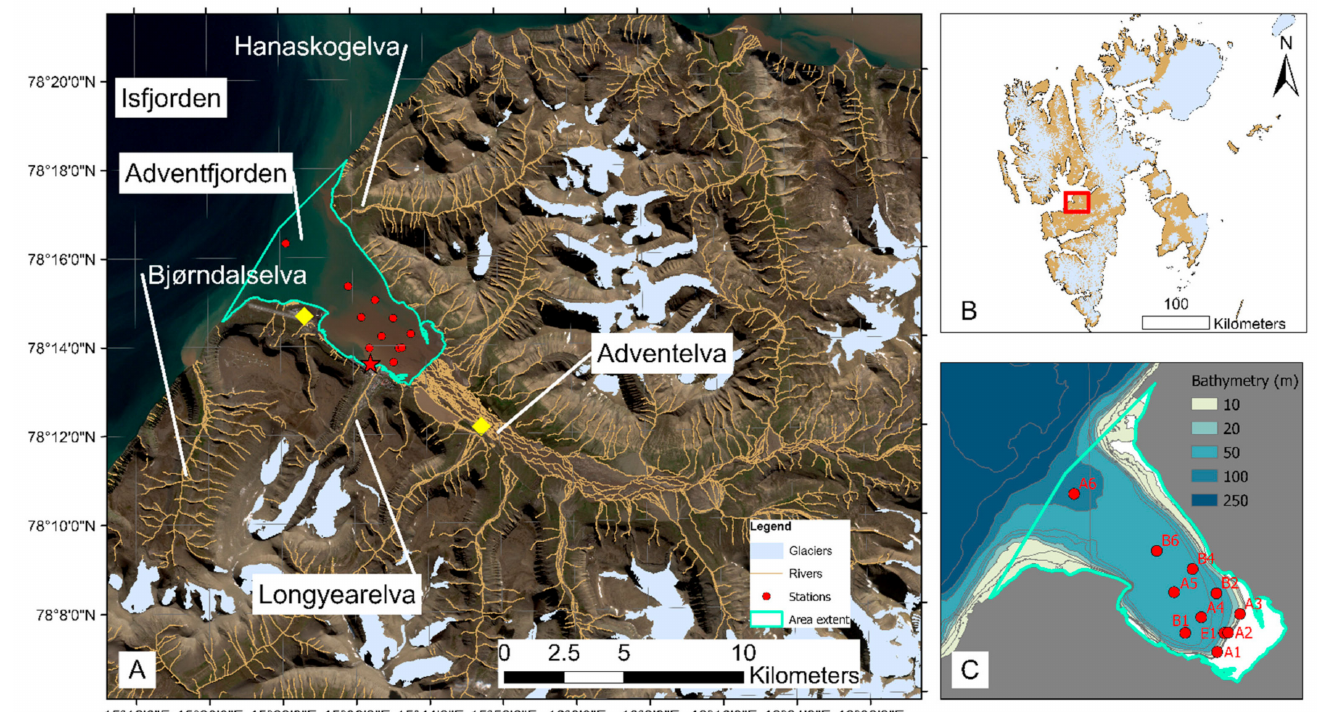
Figure 1. ( A ) Map of the Adventfjorden study area and the catchment of Adventelva and Longyearelva. Longyearbyen is marked with a red star. Yellow squares mark monitoring stations for weather (at Longyearbyen Airport) and river-hydrology (monitoring station operated by NIVA at Aventelva), ( B ) Overview of the study region in Svalbard archipelago, the highlighted outline indicating the area of interest (AOI) shown in ( A , C ) Station map of Adventfjorden for 2019 and 2020 field campaigns within the area extent defined for Adventfjorden for the purpose of this study.(map was created based on S-100 vector data provided by Norwegian Polar Institute [50]; bathymetry data from the Norwegian Mapping Authority [51]; contains modified Copernicus Sentinel-2 data (2020, Sentinel-2 B image 27 July 2020) processed by Sentinel-Hub (https://scihub.copernicus.eu/, accessed: 28 June